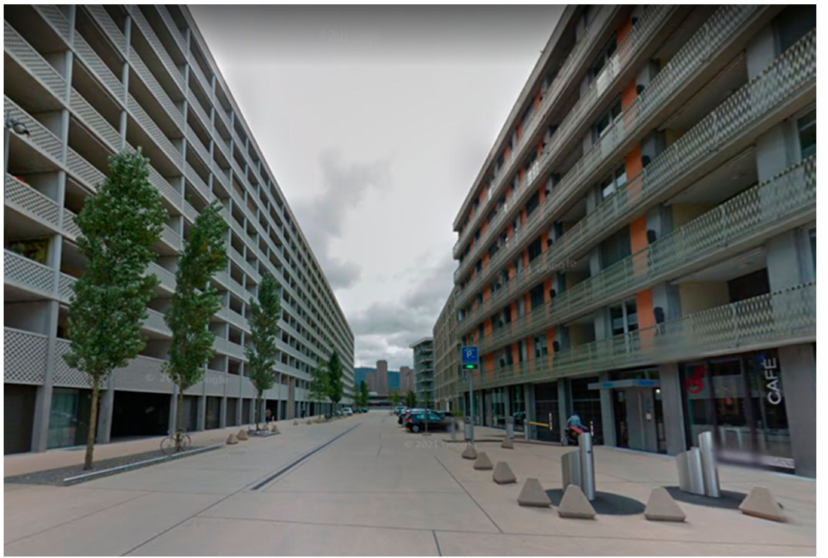
Figure 1. The Maaghof in Zurich-West